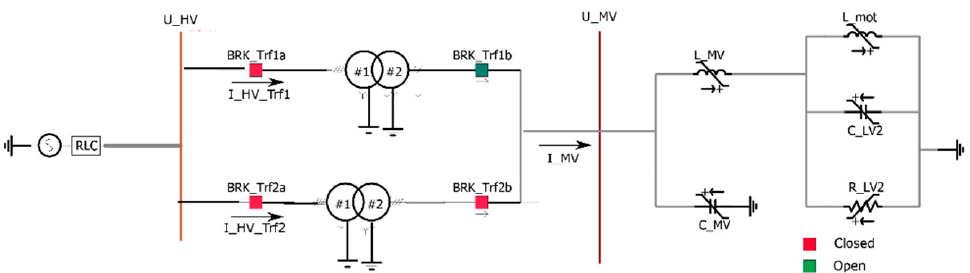
Figure 2. Distribution grid seen from the HV side.